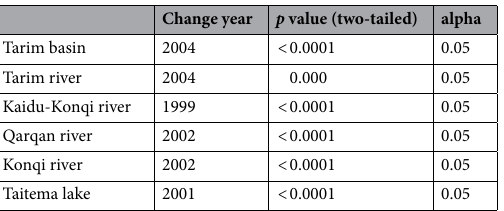
Table 2. Pettitt’s test results of surface water area in the Tarim River Basin and its tributary rivers and terminal lake.